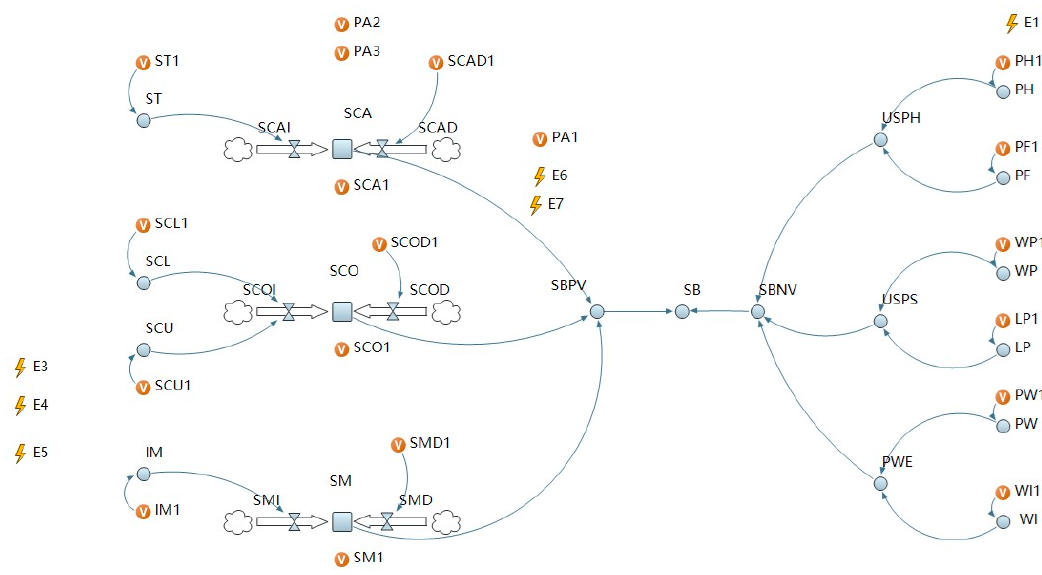
Figure 4. The passive intervention simulation model of unsafe behavior of construction workers.